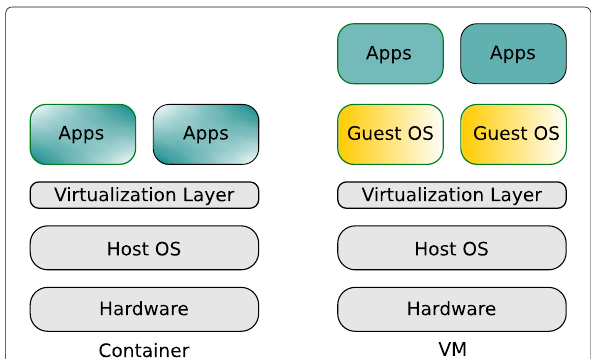
Fig. 3 Structure VMs and containers. On the VM side, the virtualisation layer often appears to be Hypervisor while on the container side it is the container